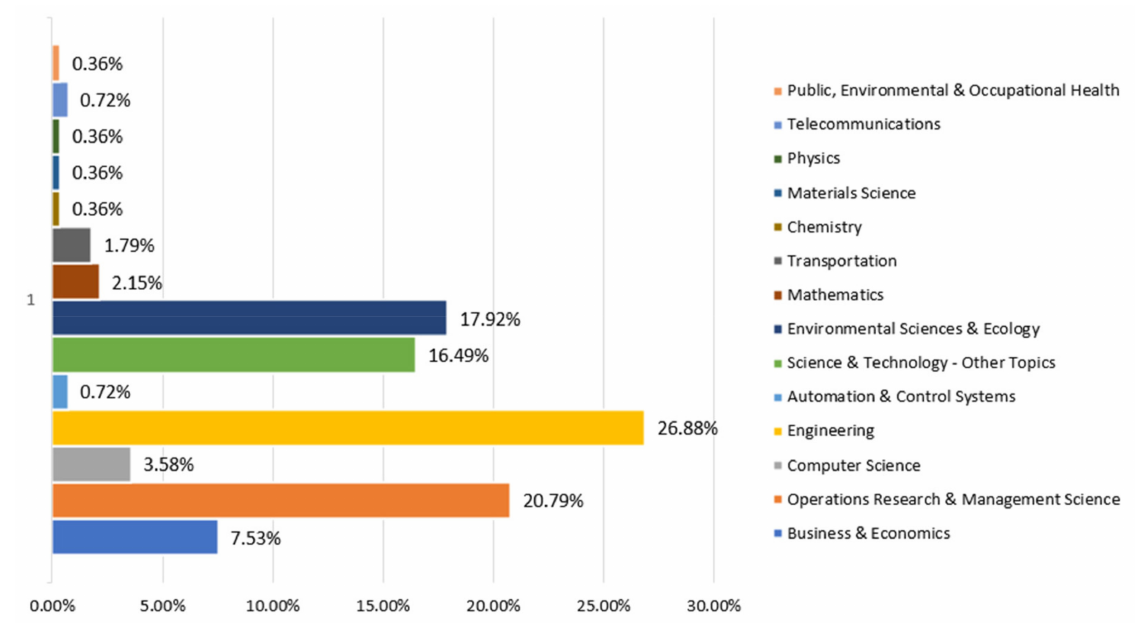
Figure 2. Subject categories.